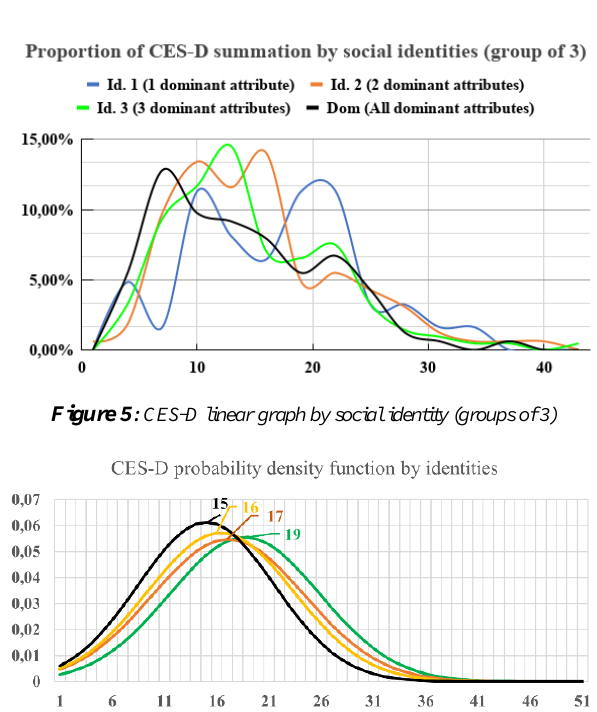
Figure 4 : CES-D linear graph by social identity